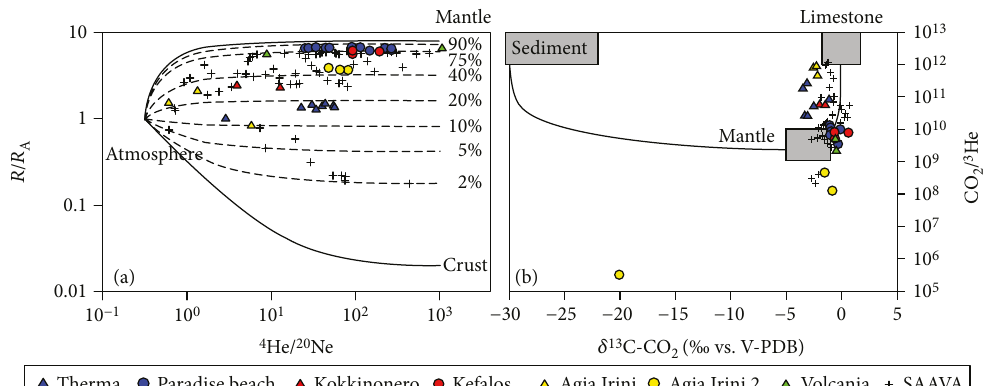
Figure 4: (a) Binary plot of R / R vs. 4 He/ 20 Ne of the Hellenic gas emissions. The mixing lines between the atmosphere and mantle and A between the atmosphere and crust are also plotted. Dashed lines represent mixing between the atmosphere and endmembers, with di ff erent percentages of mantle contribution; (b) binary plot of CO / 3 He vs. δ 13 C-CO . The compositions for sediments, MORB-like 2 2 = − 30 ‰ , -5 ‰ , and 0 ‰ , respectively, and CO / 3 He = 1 × 10 13 , 2 × 10 9 , and 1 mantle, and limestone endmembers are as follows: δ 13 C- CO 2 2 × 10 13 , respectively, [41]. SAAVA data from [14, 35, 36, 42 – 44].